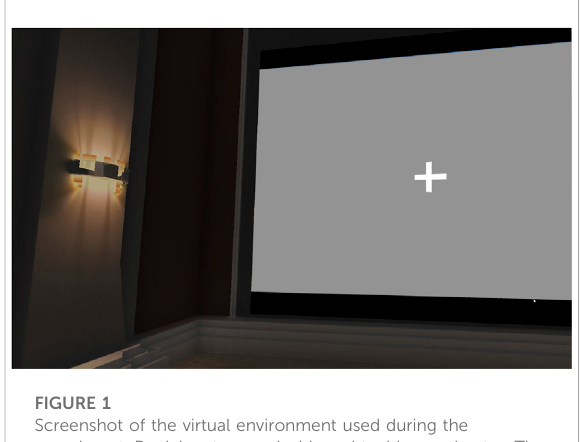
FIGURE 1 Screenshot of the virtual environment used during the experiment. Participants were inside a virtual home theater. The videoswereprojectedonthescreenofthishometheaterusingthe software Virtual Desktop (Guy,